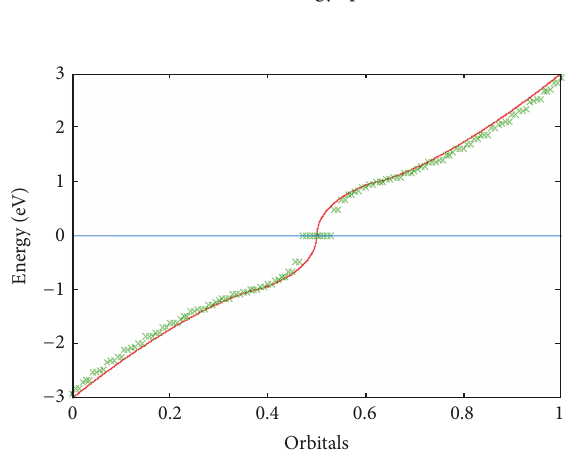
Figure 6: T 10 energy spectrum.